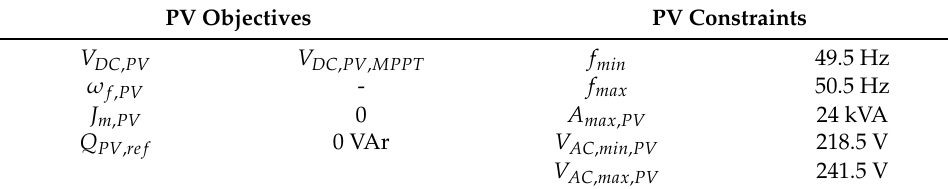
Table 8. PV Controller parameters. PQ